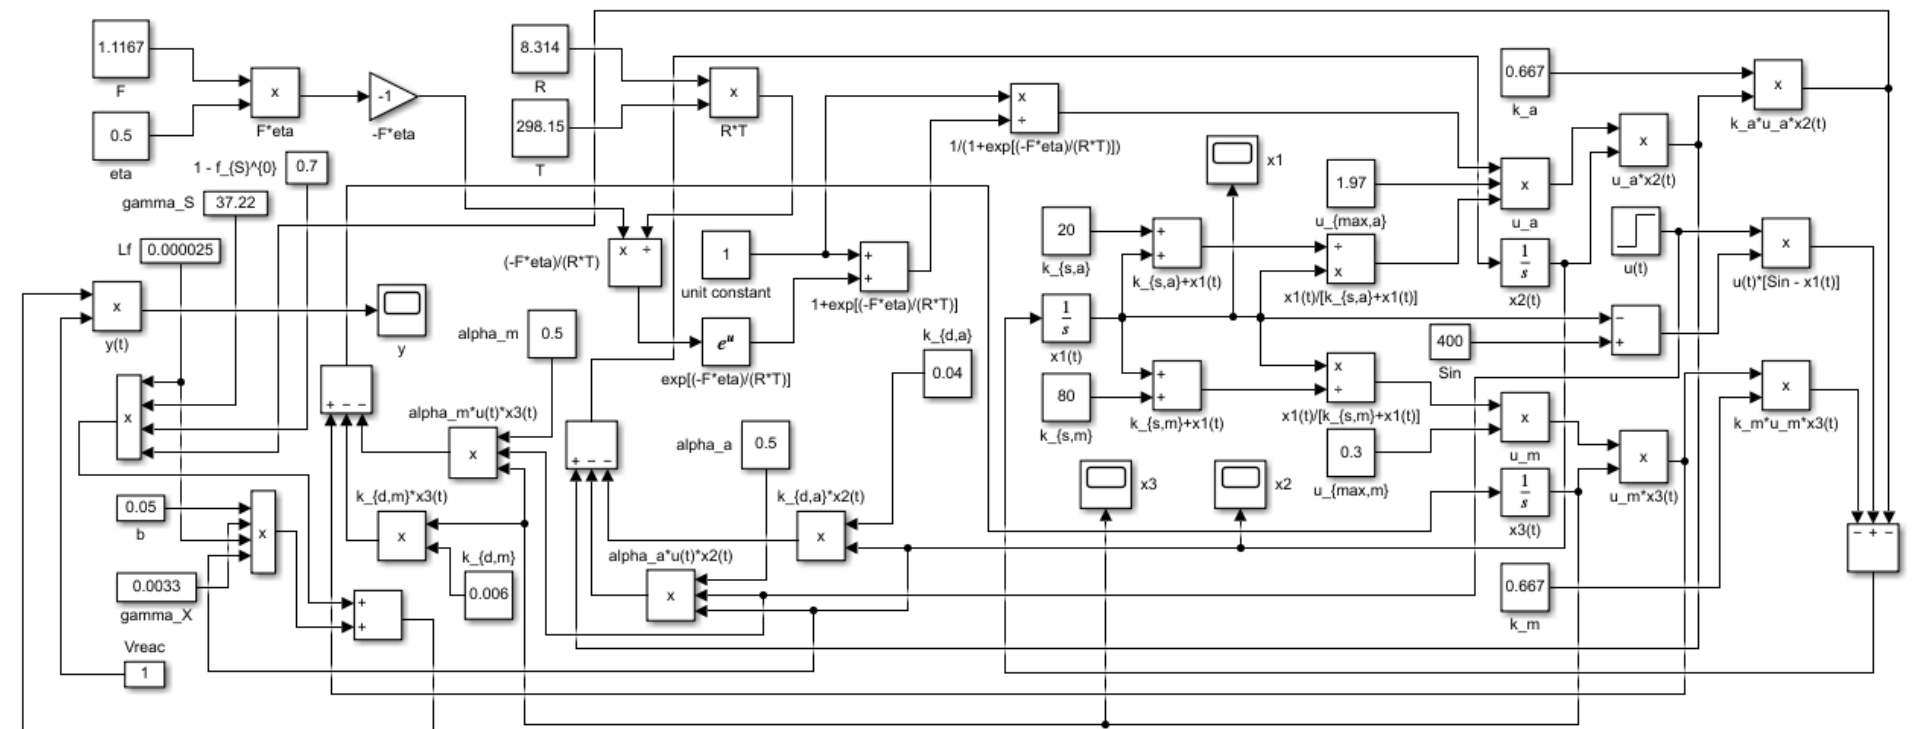
Figure 2. Diagram of the SIMULINK nonlinear state-space model of the continuous-reactor MEC process, where “*” means the multiplication symbol, as usual in programming